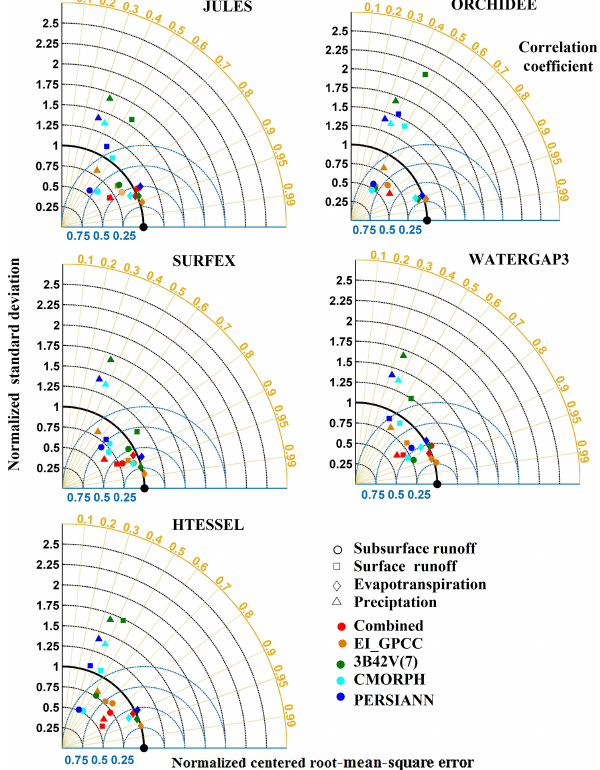
Figure 10. Normalized Taylor diagrams for daily simulated hydro- logical variables with SAFRAN and the satellite–reanalysis precip- itation products